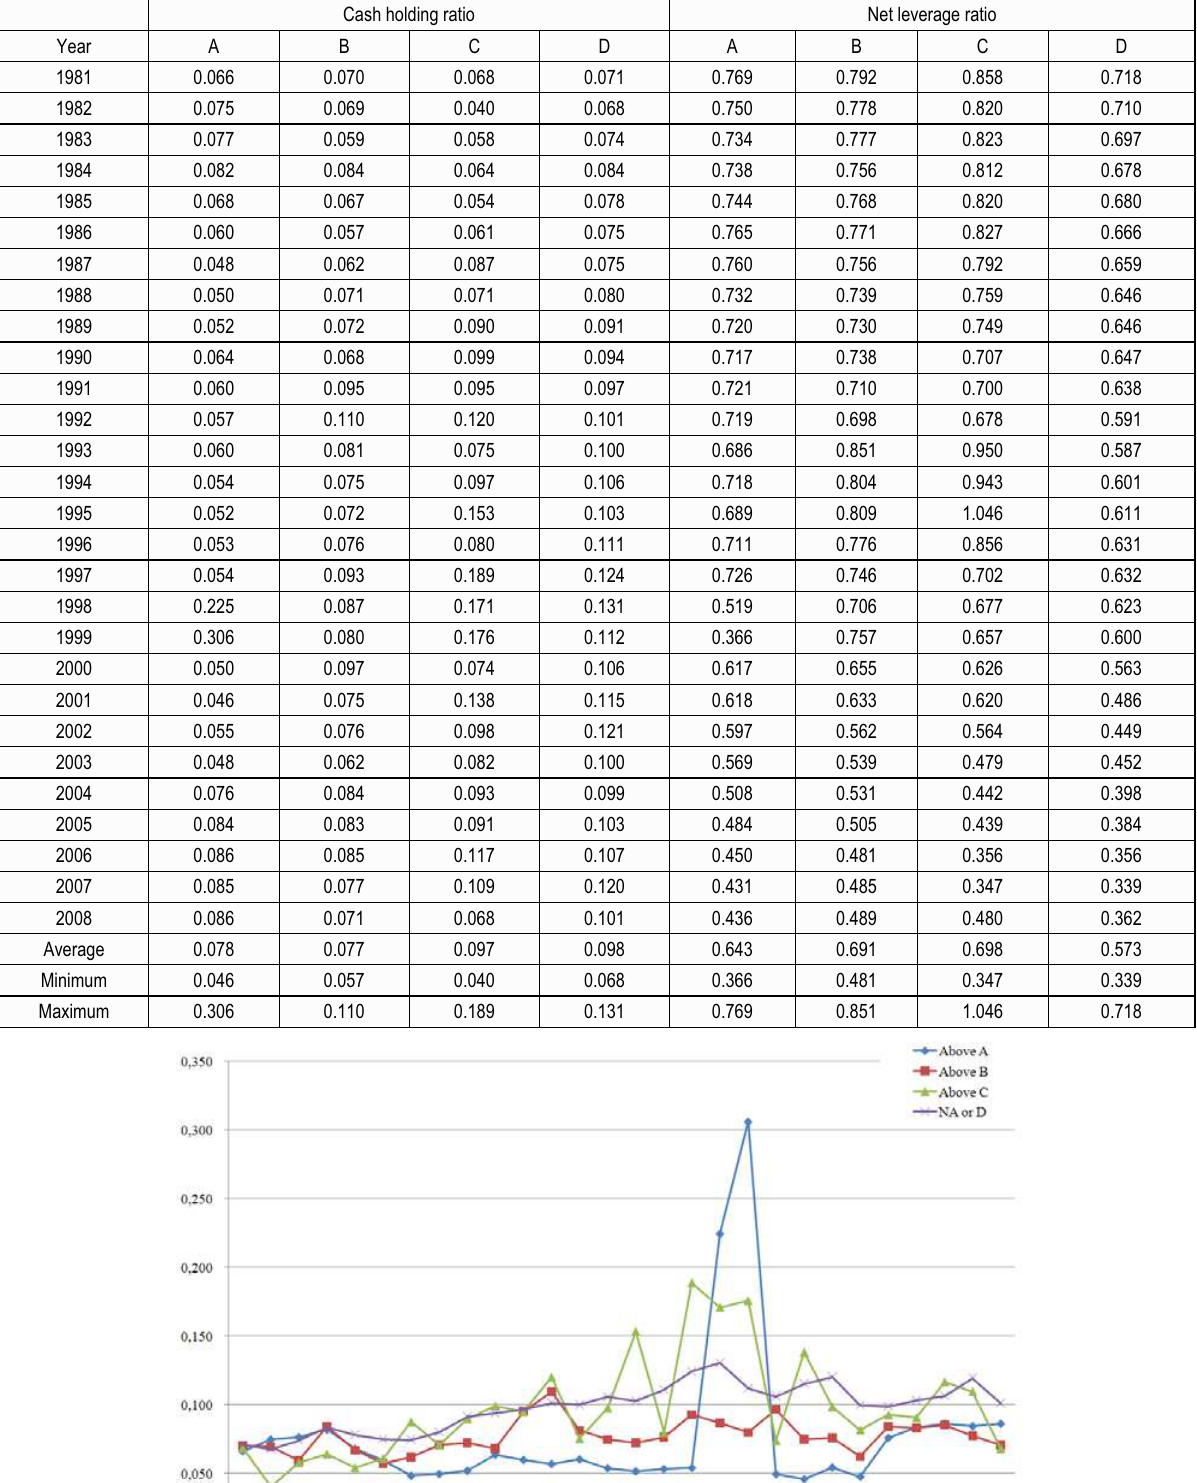
Table 3. Cash holding and net leverage ratios by credit rating The cash holding ratio is defined as cash and marketable securities divided by total assets. The net leverage ratio is defined as the leverage net of cash and cash equivalent divided by net assets. The bond dumours are A, including A-, A, A+, AA(-,·, +), AAA(-,·, +); B, including B(-,·, +), BB(-,·, +), BBB(-,·, +); C, including C(-,·, +), CC(-,·, +), CCC(-,·, +); D, including D group ratings; and NA for unidentified ratings. These credit ratings are the most conservative ones among 3 major credit rating agencies in Korea: KBP, NICE, and KIS.